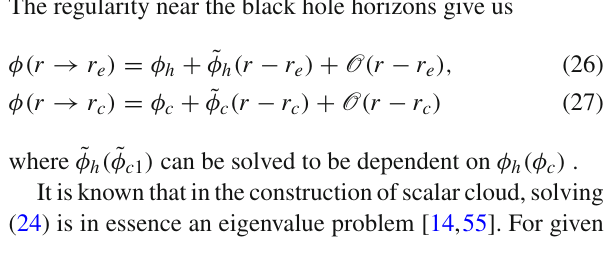
Fig. 10 The unstable/stable region of SdS black hole under massive scalar perturbation with (cid:4) = 0 , 1 , 2 and 3 from fundamental QNM frequency